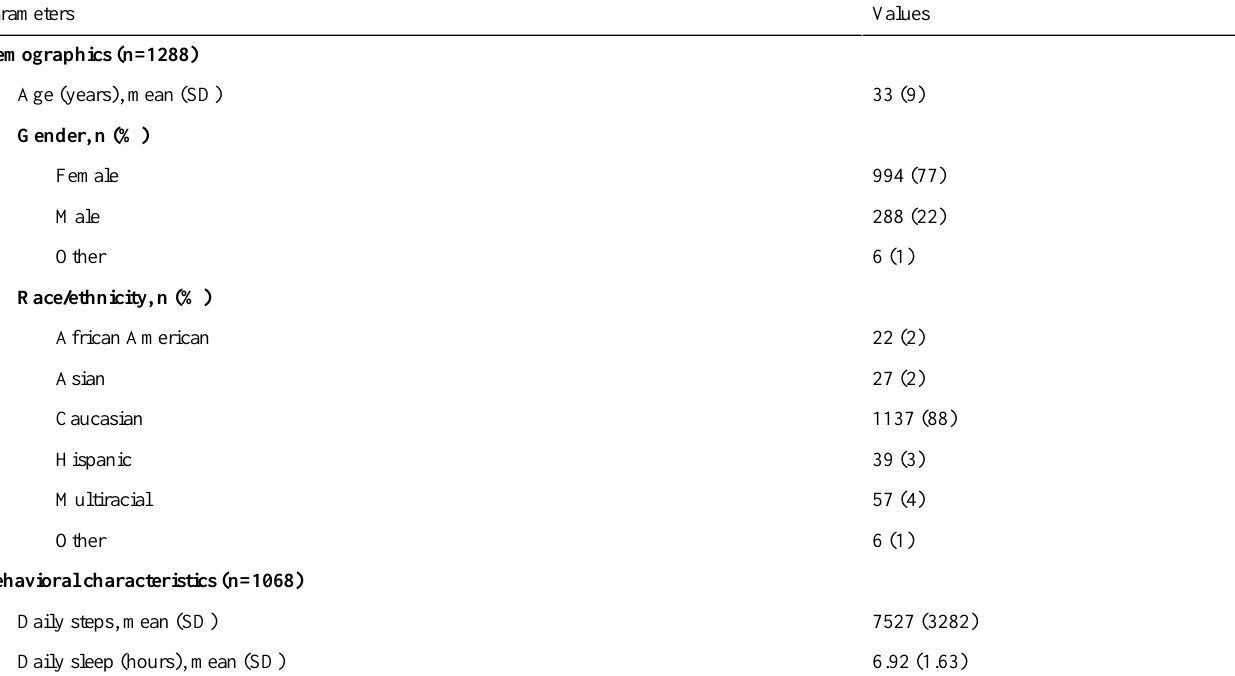
Table 2. Baseline demographics and behavioral characteristics of enrolled